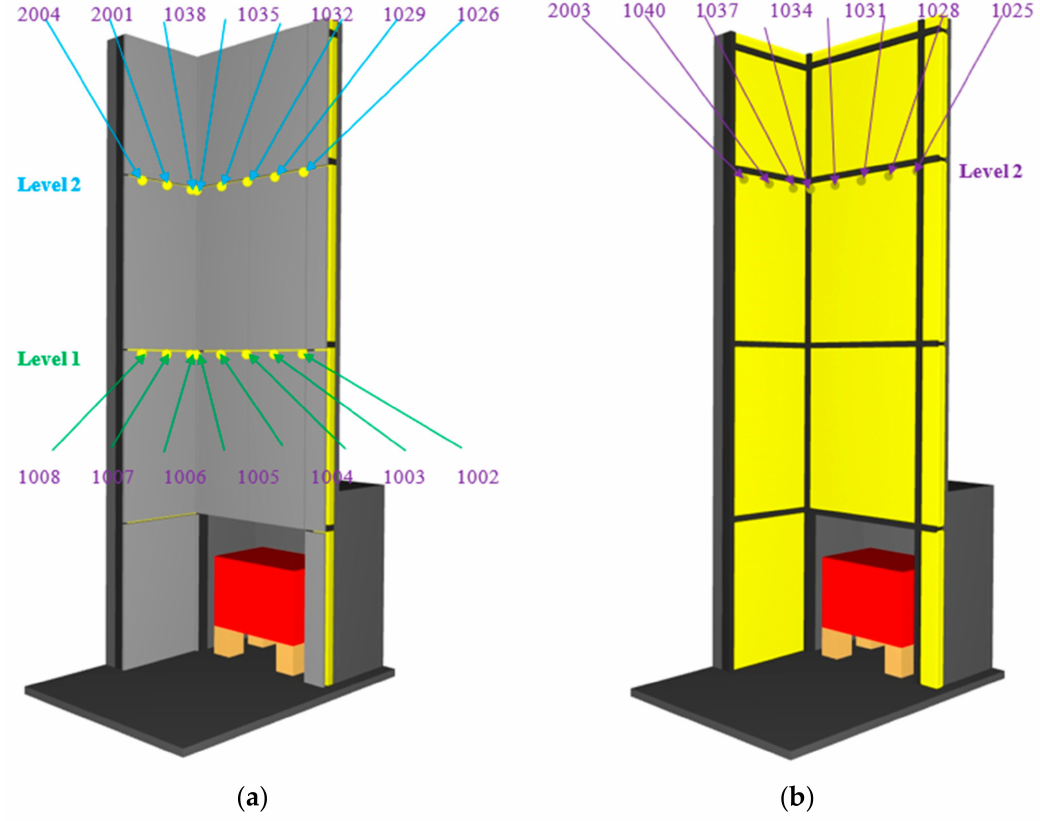
Figure 3. ( a , b ) Levels and locations of thermocouples used in the FDS